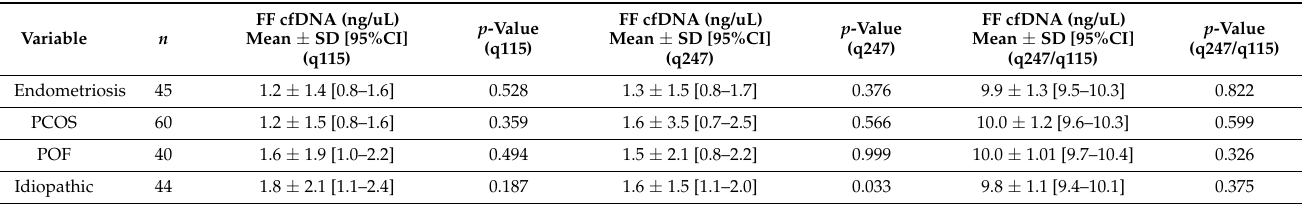
Table 2. Cell-free DNA levels according to infertility factor.